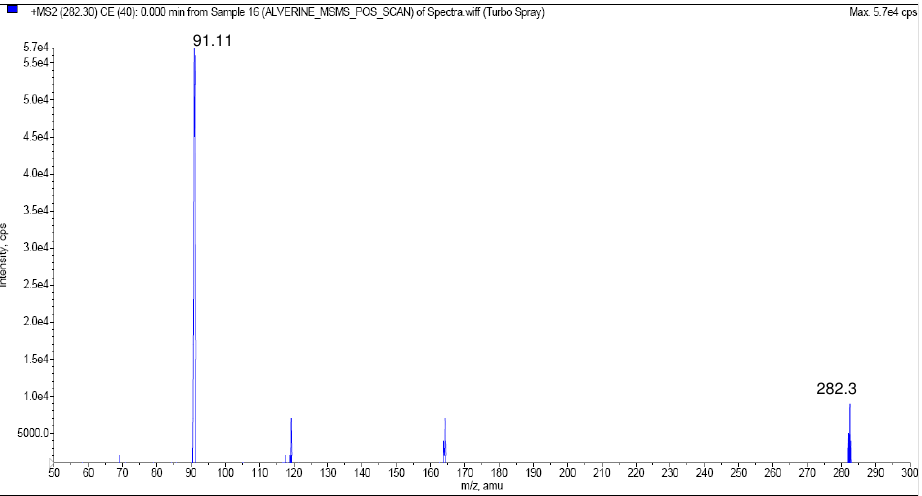
Figure 2. Product ion mass spectra of the [M+H] + ions of